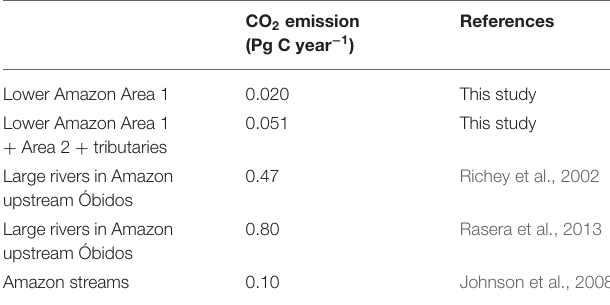
TABLE 4 | CO 2 emission estimates for rivers and streams in the